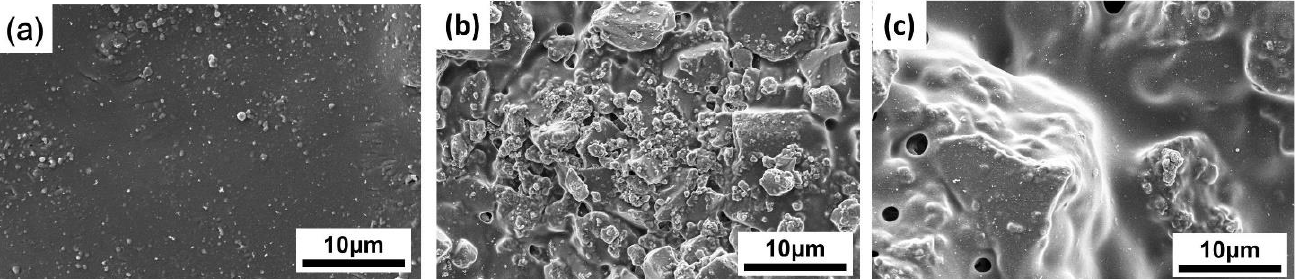
Figure 7. SEM images of the char residues of ( a ) PLA/APP, ( b ) PLA/serpentine, and ( c ) PLA/serpentine@APP.